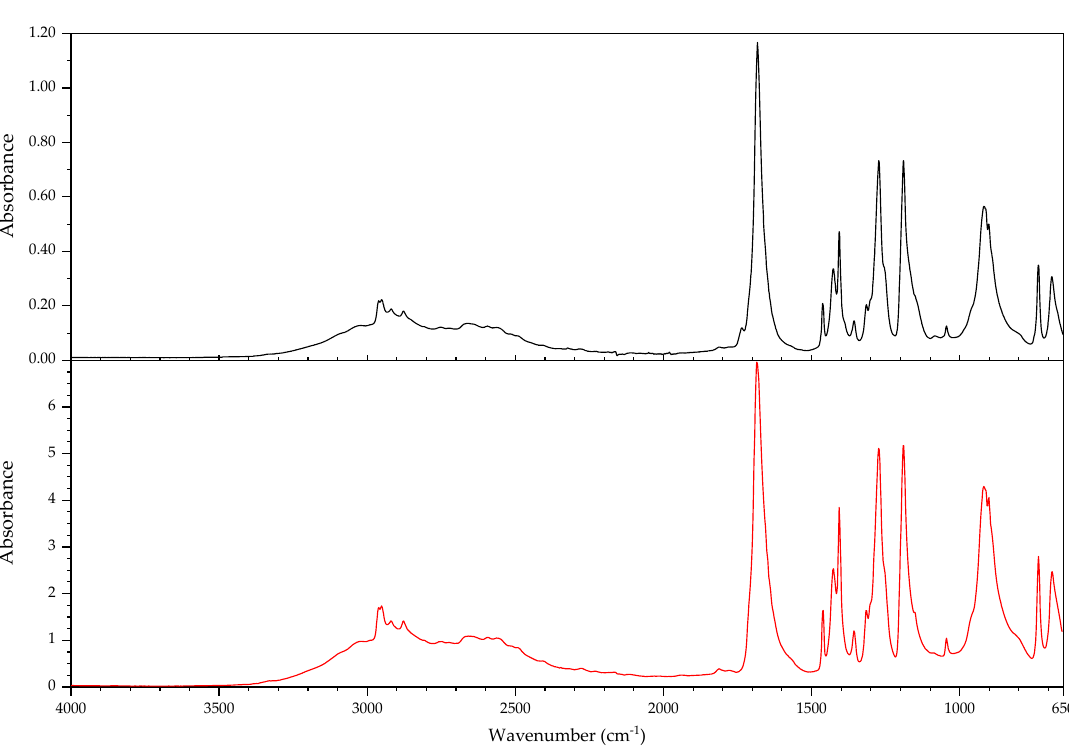
Figure 25. FTIR spectrum of the blooming of object 610 (black line) compared to reference spectrum of adipic acid (red line) from a commercial database.